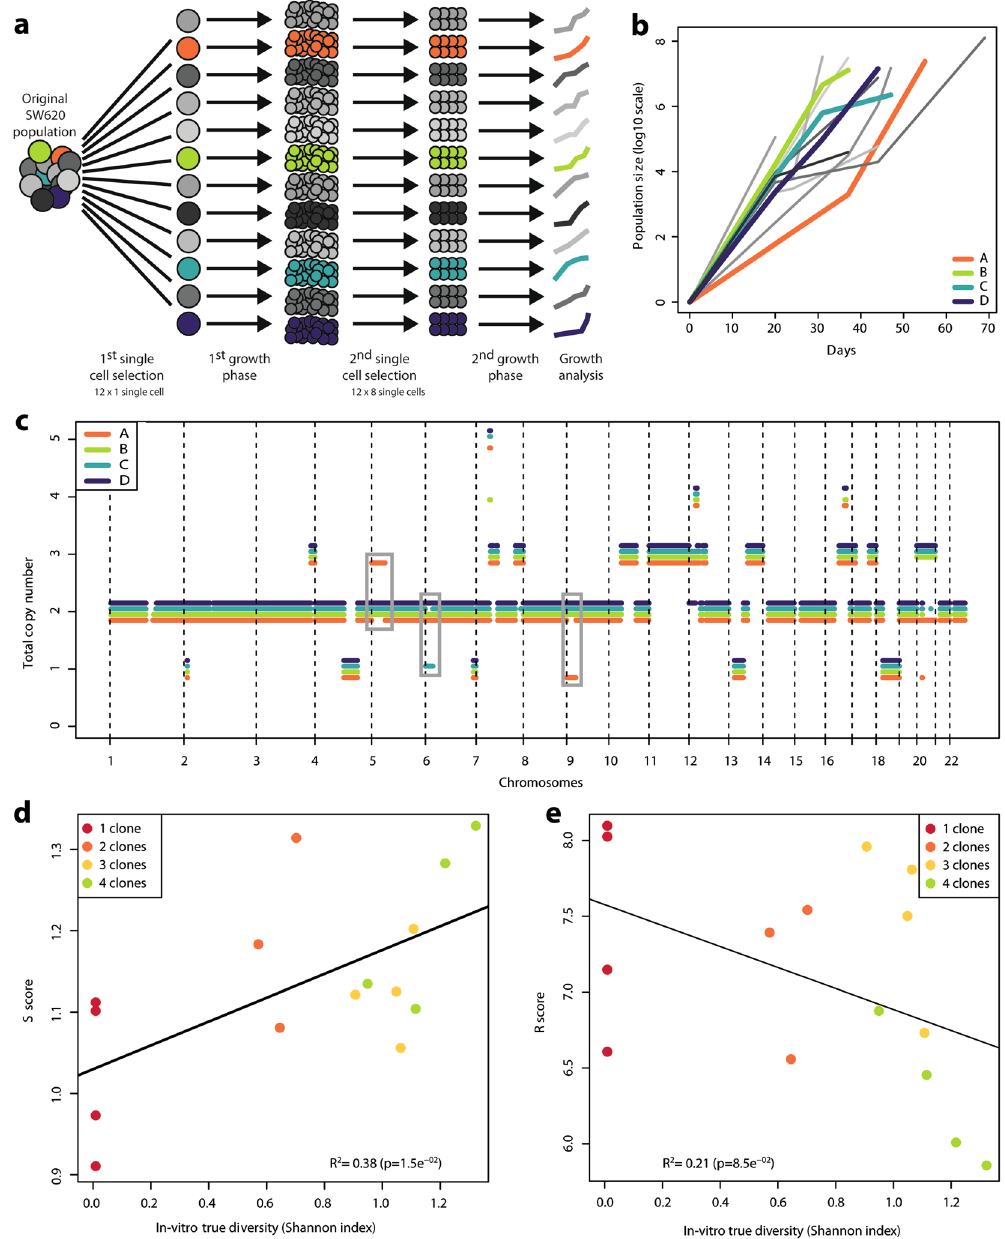
Figure 4. In-vitro clonal mixtures. ( a ) Experimental procedure. ( b ) Growth curves of 12 single cell cloned isogenic cell lines. In colour, the 4 cell lines that were selected for further characterisation and in-vitro mixing of DNA. ( c ) Total copy number profiles of A, B, C and D, the 4 selected cell lines. Grey rectangles highlight regions where one profile showed marked divergence with the others. Vertical dashed lines indicate chromosome boundaries. ( d , e ) Correlation of the S score ( c ) and R score ( d ) with the true diversity in in-vitro mixtures. Black lines indicate the linear fit between the scores and the expected